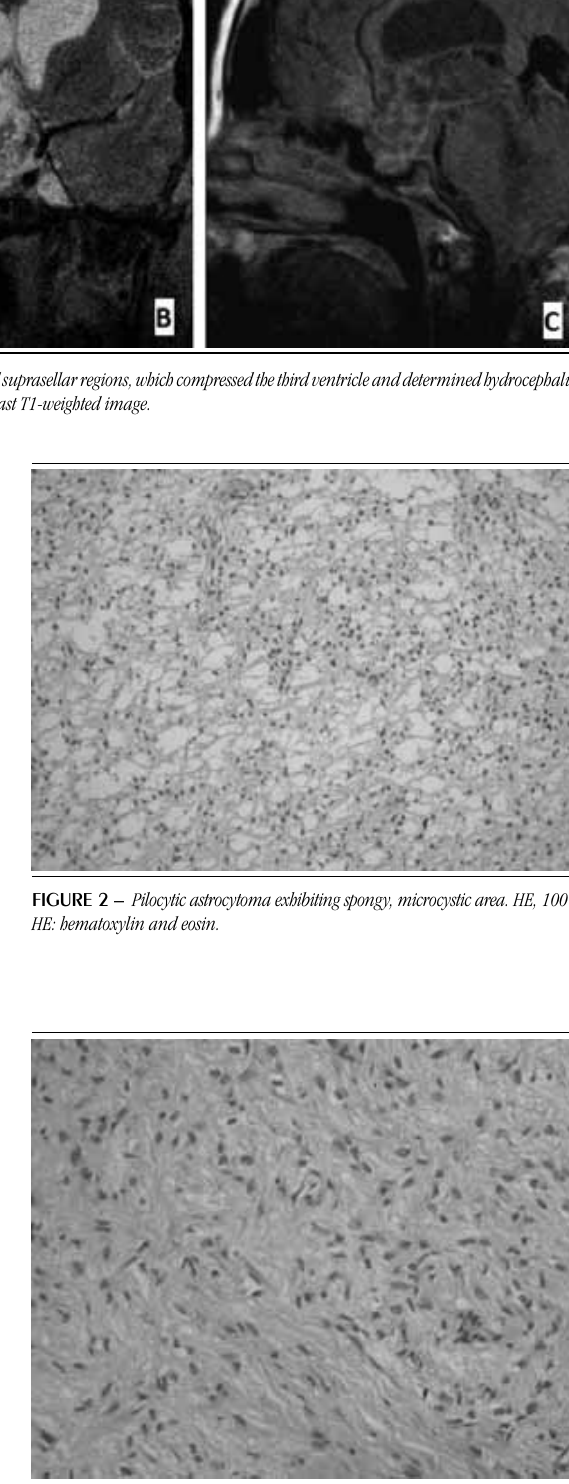
figurE 3 – Pilocytic astrocytoma exhibiting occasional Rosenthal fibers. HE, 200× HE: hematoxylin and